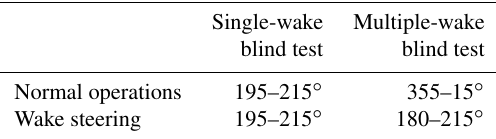
Table 2. Summary of wind direction ranges for each of the blind